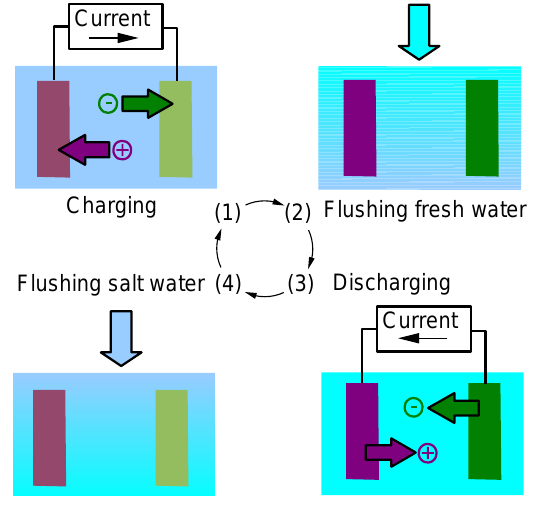
Figure 2. Cycles of the accumulator mixing (AccMix) technique. The cycle starts with the cell filled with the high concentration solution. The phases are: (1) charge; (2) flow of dilute solution; (3) discharge; (4) flow of concentrated